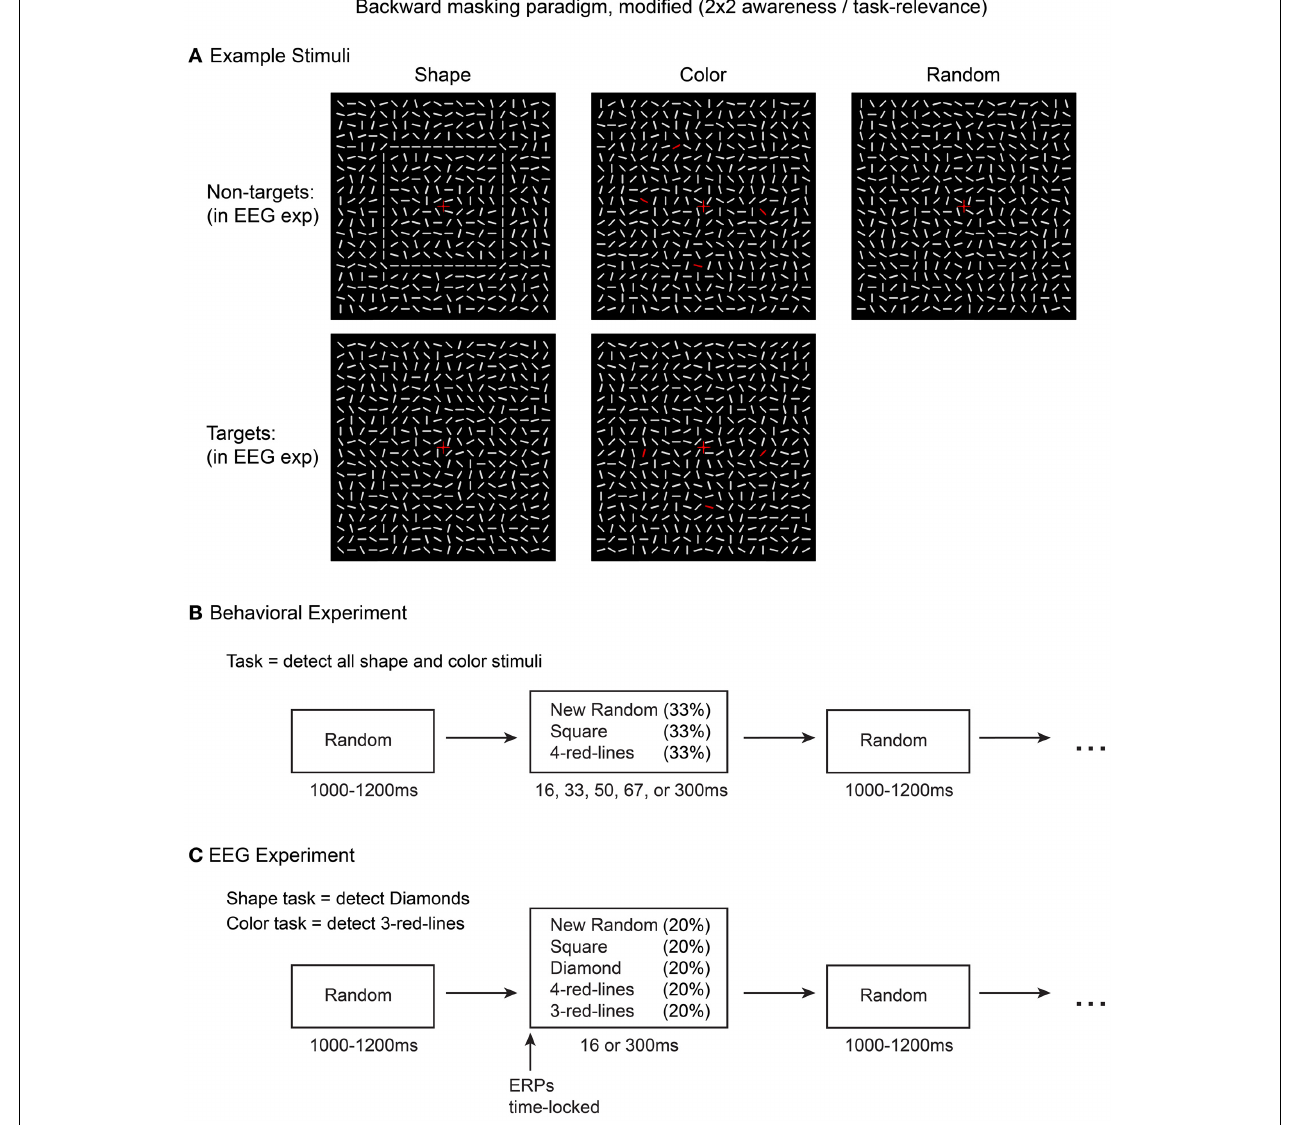
FIGURE 3 | Stimuli and methods used in the current experiment. Five types of stimuli (A) were presented in the EEG experiment (C) while awareness was manipulated via short vs. long masking SOAs (16 or 300ms).